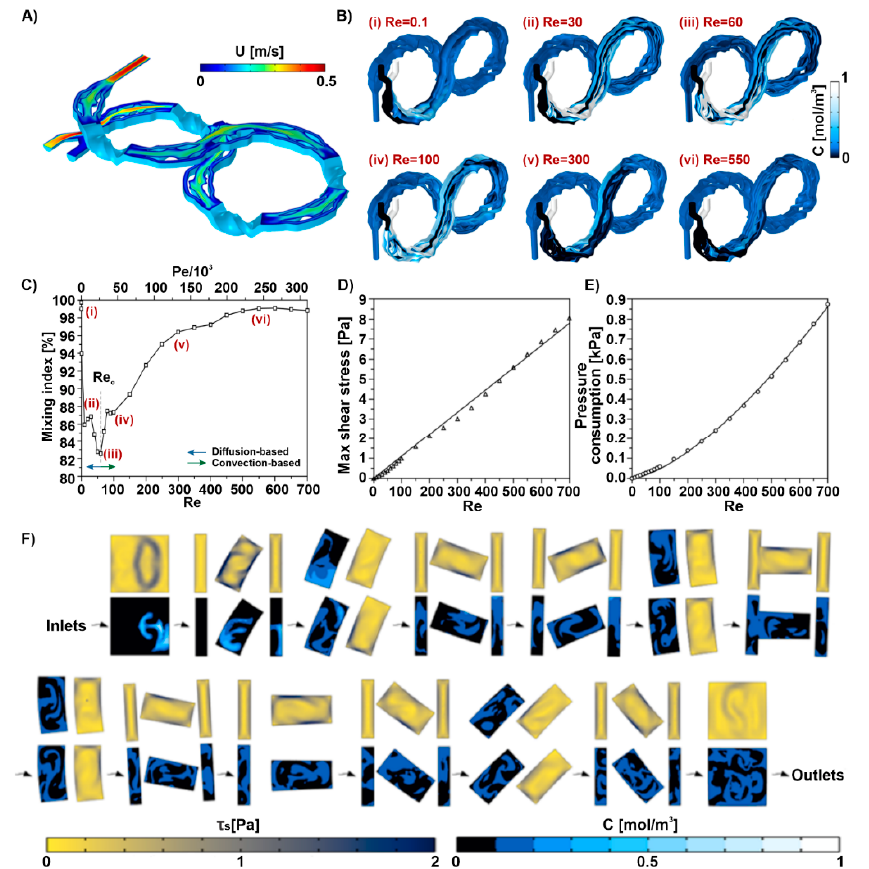
Figure 2. Simulation results demonstrate the mixing performance, pressure, and shear stress in the micromixer. ( A ) Velocity changes on the mid-plane at 𝑅𝑒 = 550 . The alteration of pathways and the complex geometry induce velocity shifts and, thus, chaotic and secondary flows. ( B ) The con- centration distributions on the micromixer’s walls at different 𝑅𝑒 , representing the mixing mecha- nisms. ( C ) The calculated mixing index at various operational Reynolds numbers. The correspond- ing 𝑅𝑒 to minimum M.I. is known as the critical Reynolds ( 𝑅𝑒 (cid:3004) ), representing the mixing mecha- nism’s transition from diffusion to convection. ( D ) The maximum shear stress during the mixing as a criterion for cell viability. Although it exceeds the physiological limit of 6 Pa, short exposure time, as well as a small coverage area, allow most of the cells to stay alive at the end of the mixing cycle. ( E ) Pressure usage at different Reynolds numbers highlights the relatively small pressure require- ment. ( F ) The changes in concentration and shear stress distribution at cross-sections inside all 12 units at 𝑅𝑒 = 550 . The dispersion of 0.1 mol/m 3 entails the effectiveness of the device.